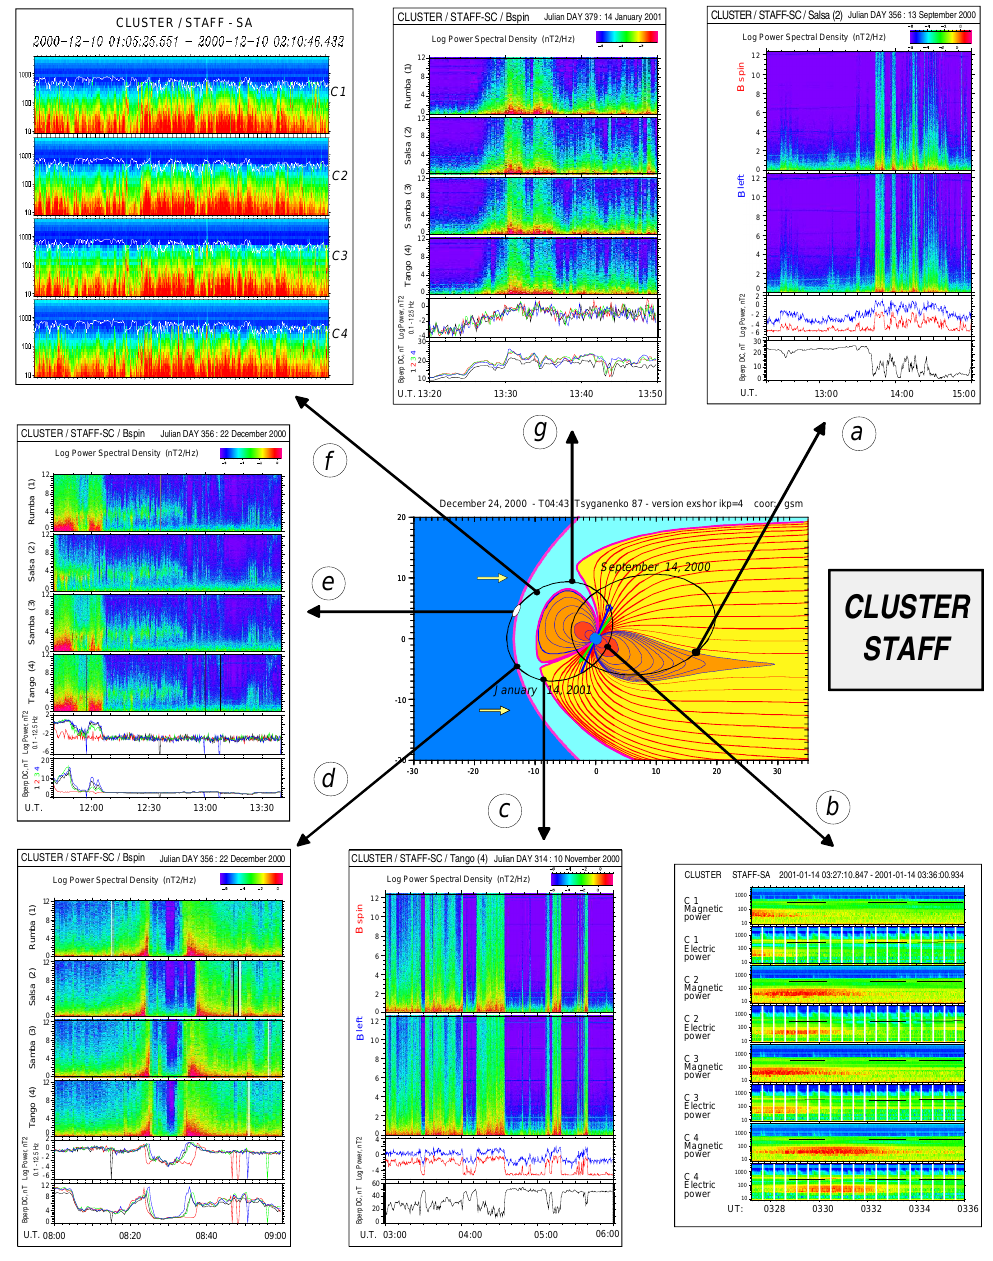
Fig. 3. Overview of some STAFF observations. The middle panel is a magnetospheric representation in the noon-midnight meridian plane where the magnetic field lines come from the Tsyganenko 1987 model. The projection of 2 orbits of cluster in this plane are plotted, for 14 September 2000 and 14 January 2001. The arrows show where the data have been acquired. panels (a), (c), (d), (e), and (g) are dynamic spectra of the magnetic waveform data in the 0–12Hz frequency range. Below is represented the integrated power in this frequency range and the bottom panel represents the DC component of the magnetic field in the spin plane as deduced from the STAFF spin signal. For panels (a) and (c), 2components of a single spacecraft data are plotted. For panels (d), (e) and (g), one component of the 4 spacecraft are represented. For the curves, the colour code is the “standard” Cluster one: black for SC1, red for SC2, green for SC3 and blue for SC4. Panels (b) and (f) are dynamic spectra obtained from the Spectrum Analyser in the frequency range 10Hz–4kHz, spacecraft 1 to 4 being plotted from top to bottom. The different examples: (a) – plasmasheet crossing; (b) – successively B and Ecomponents close to perigee when Cluster crosses the equatorial plane at 03:00LT; (c) – magnetopause crossings at about 18:00LT; (d) – two successive bow shock crossings; (e) – shock crossing and upstream waves; (f) – waves in the magnetosheath, the white line being the electron gyrofrequency; (g) – the first cusp crossing observed by